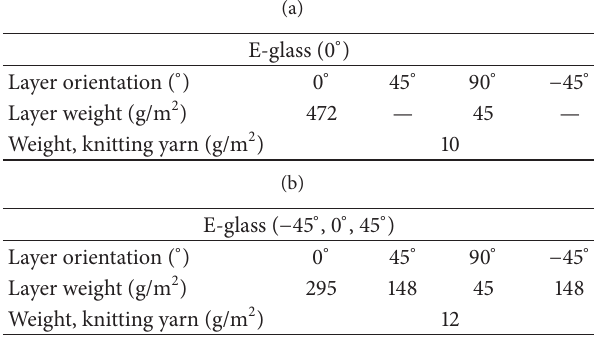
Table 1: Specifications of the fiberglass